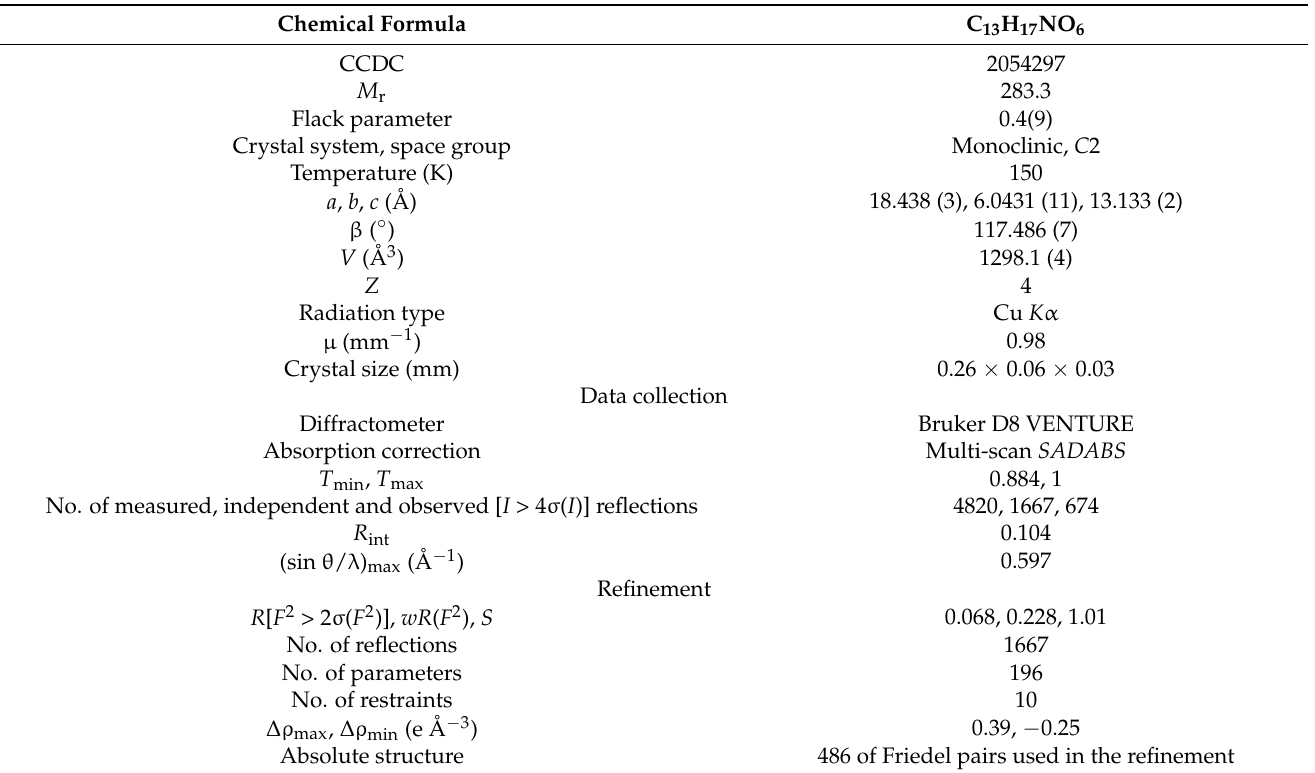
Table 1. Refined data of the GASB-1